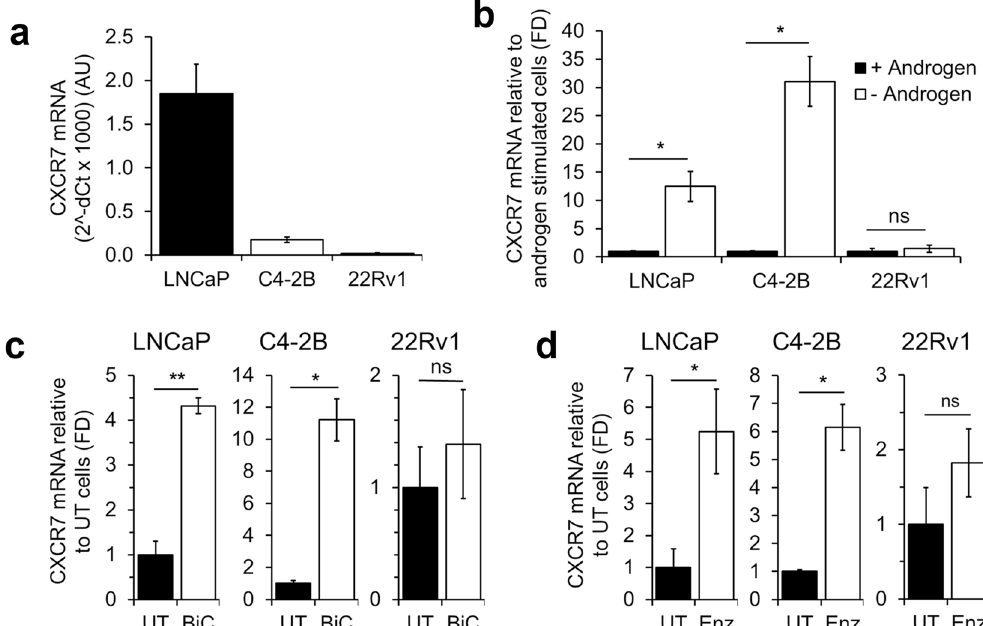
Figure 1. Androgen deprivation and AR inhibition result in increased CXCR7 mRNA transcription in androgen-responsive prostate cancer cells. ( a ) CXCR7 mRNA abundance in LNCaP, C4-2B, and 22Rv1 cell lines relative to PPIA. ( b ) CXCR7 mRNA transcription in androgen deprived cells relative to androgen stimulated cells. ( c ) CXCR7 mRNA in cells treated with 2 µ M bicalutamide (BiC) relative to untreated (UT) cells. ( d ) CXCR7 mRNA in cells treated with 5 µ M enzalutamide (Enz) relative to UT cells. All graphs shown include the means of 3 independent experiments, ± standard error of the mean (SEM). * p < 0.05, ** p < 0.01, ns = no significance; unpaired, two-tailed Student’s